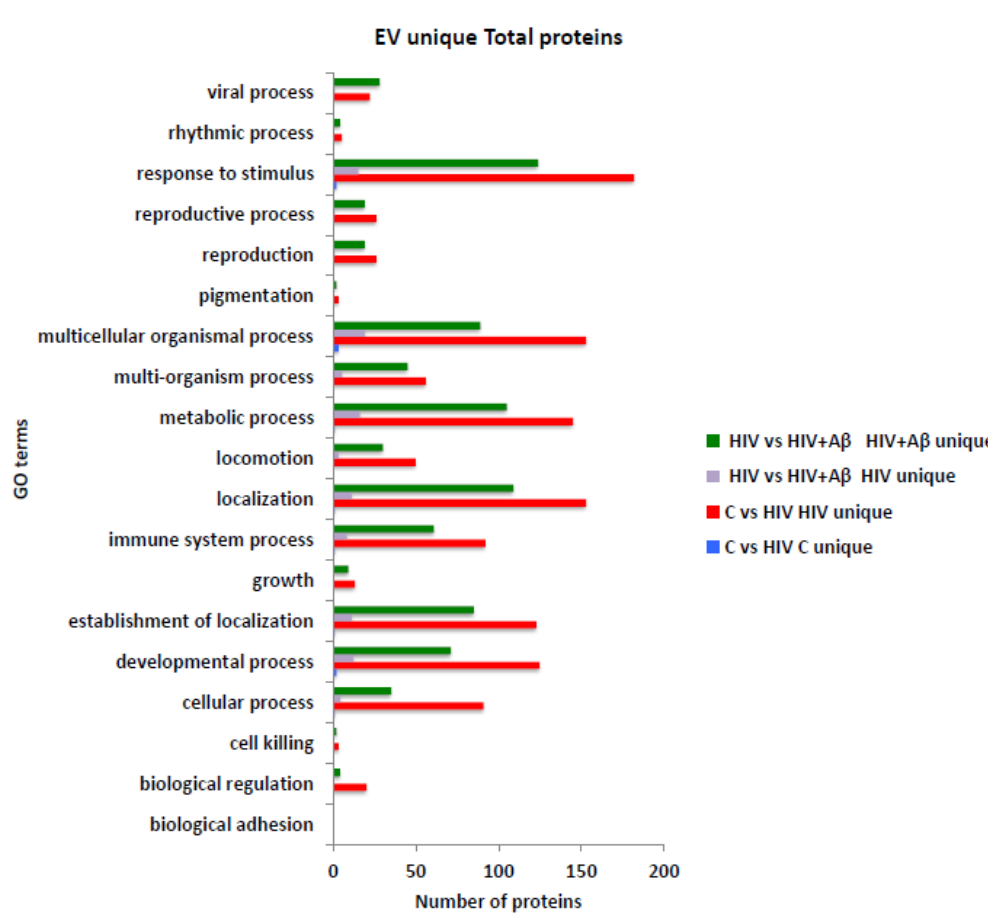
Figure 2. Enrichment for biological processes of the identified unique EV proteins. Scaffold software was used to enrich for the main biological processes for the identified unique EV proteins. The upper Venn diagrams show the compared groups with the number of their unique and shared proteins. The lower pie charts depict the enriched biological processes corresponding to the unique lists highlighted in yellow. The number of proteins in a particular biological process category is also provided. ( A ) Surface proteome, control vs. HIV. ( B ) Total proteome, control vs. HIV. ( C ) Surface proteome, HIV vs. HIV+ amyloid beta (Aβ). ( D ) Total proteome, HIV vs. HIV+Aβ. Combined graph for the biological processes in the EV unique surface ( E ) and total ( F ) proteomes. The number of unique proteins